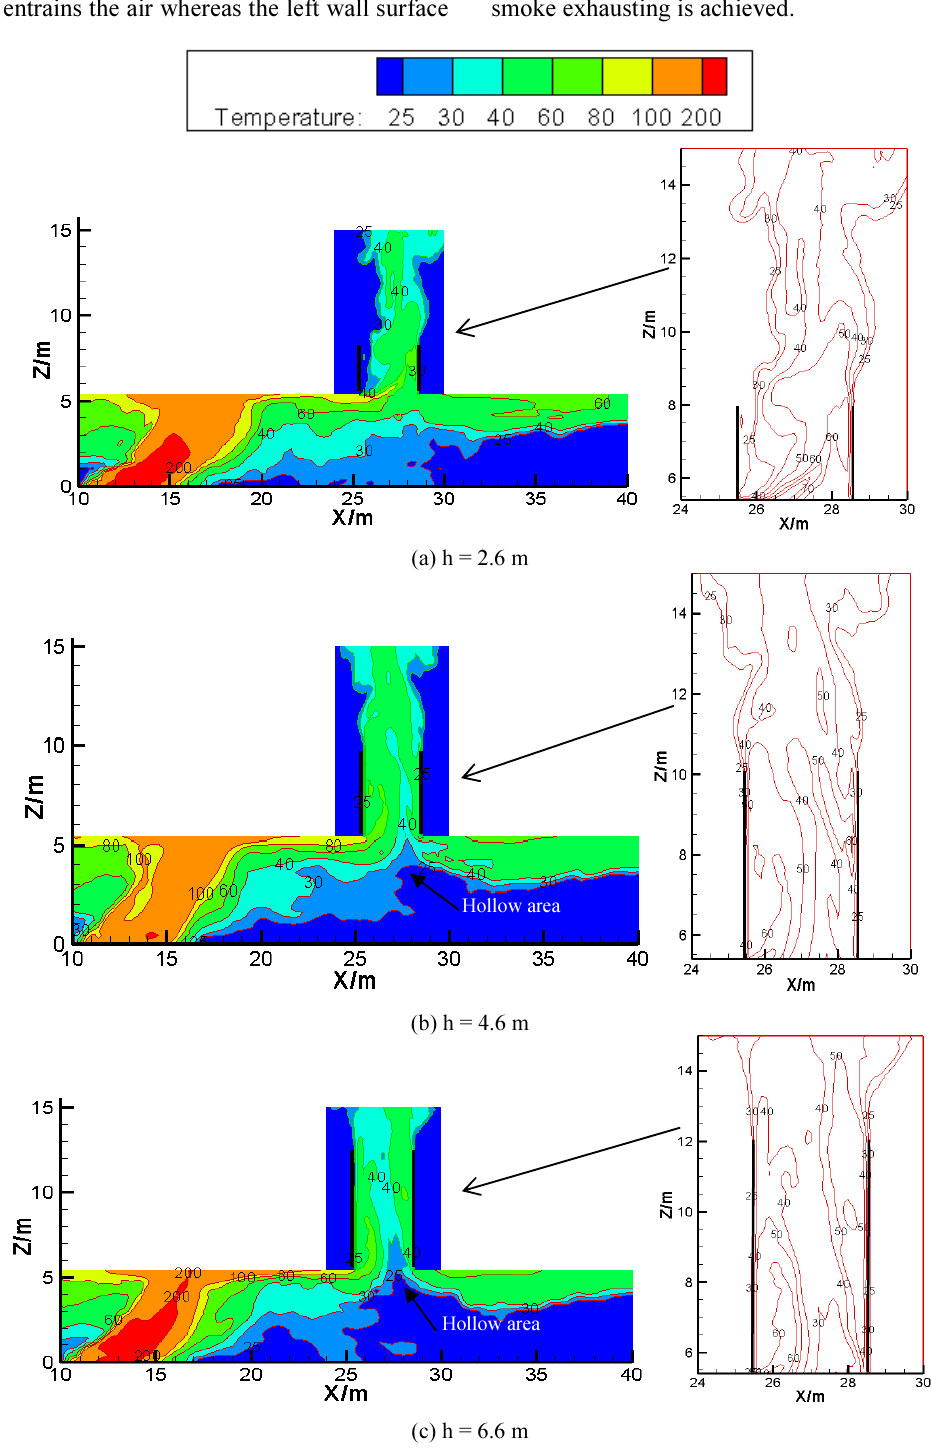
Fig. 7. Temperature field in the shaft and tunnel (the connection angle is